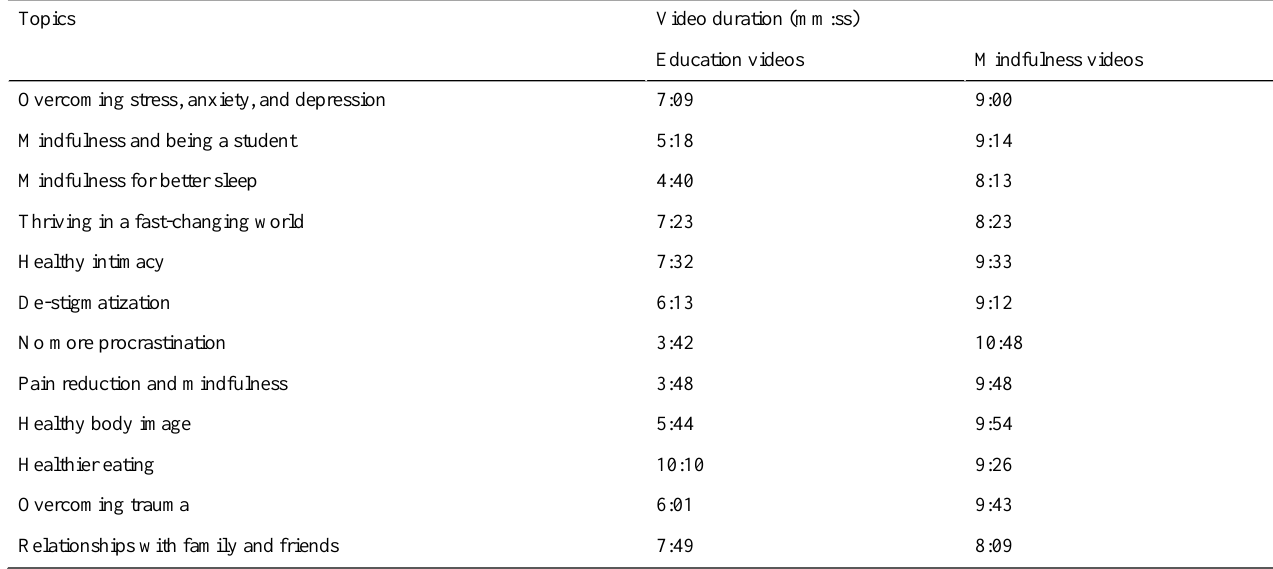
Table 1. Topics and duration of modules.